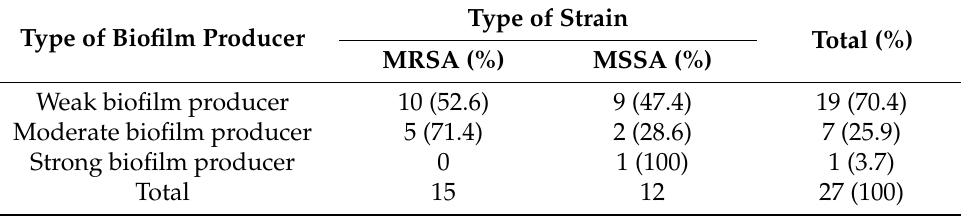
Table 4. Distribution of biofilm producers among MRSA and MSSA.